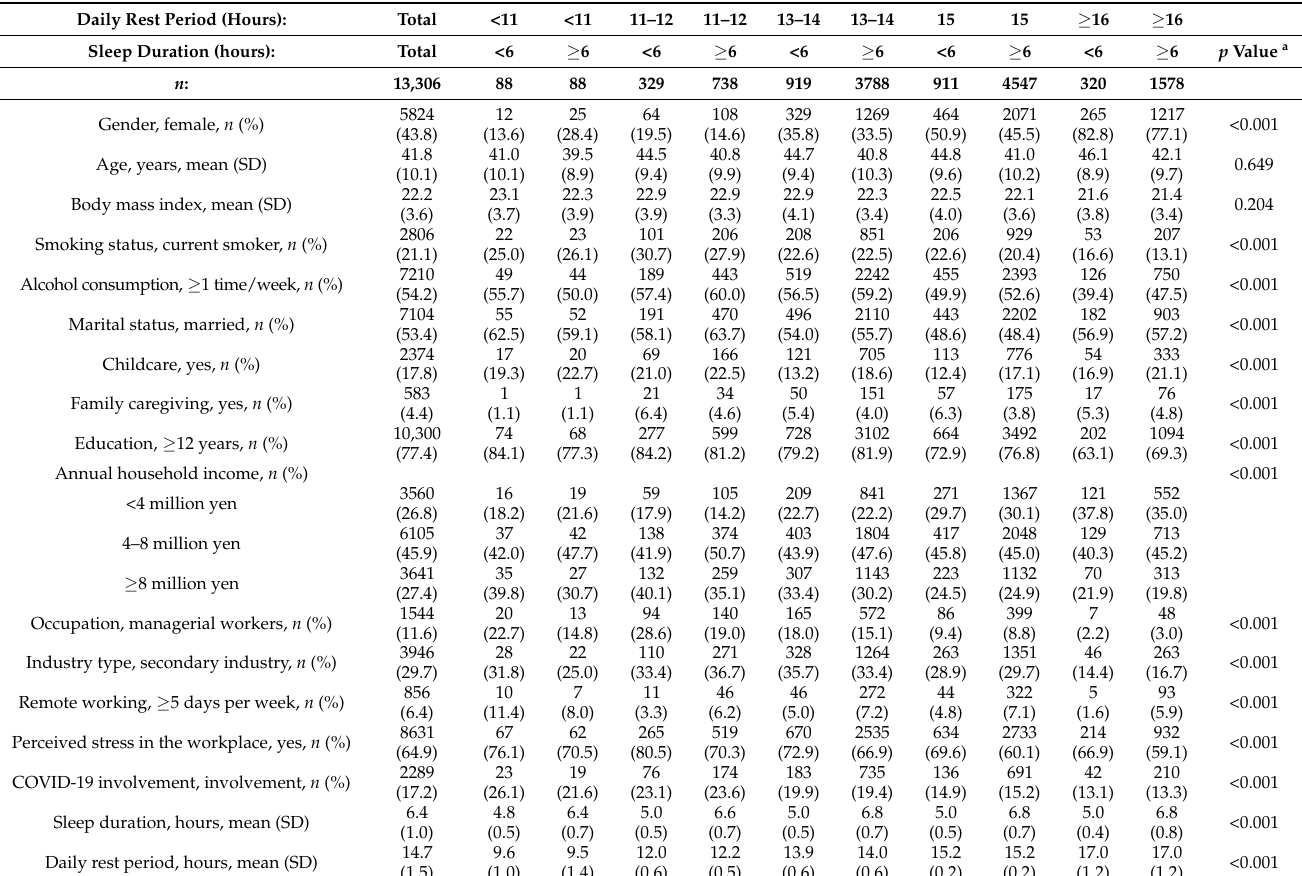
Table 1. Participant characteristics in each